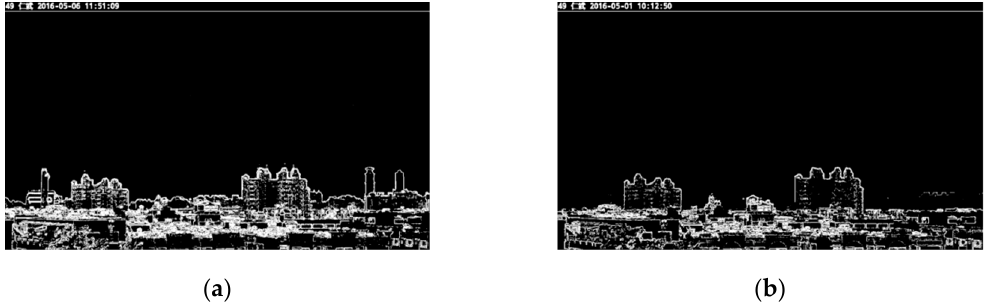
Figure 5. Images after Otsu thresholding. ( a ) I 1,so (low PM 2.5 concentration); ( b ) I 2,so (high PM 2.5 concentration).